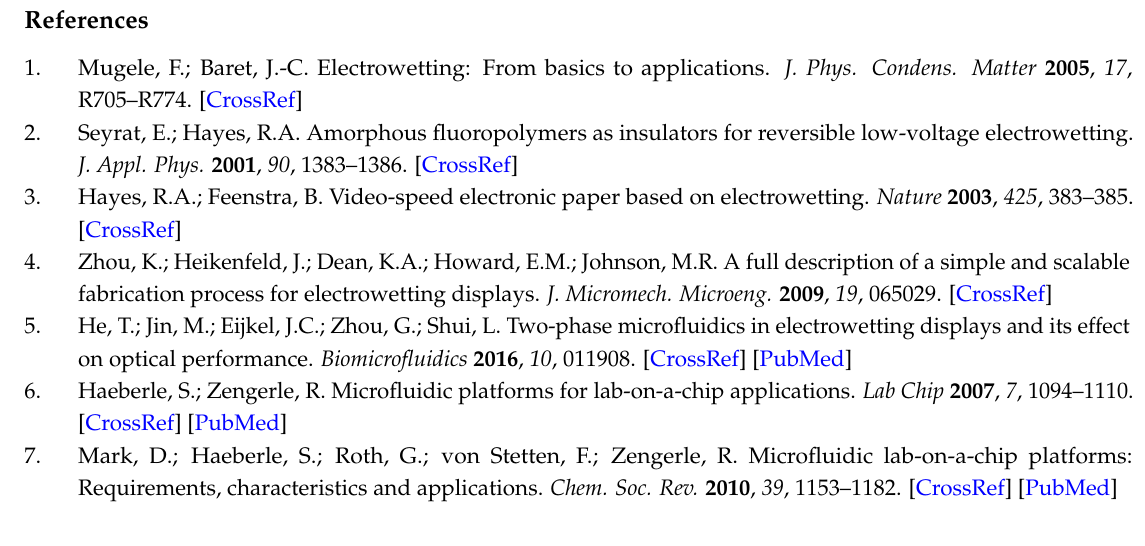
Figure S1: (a) Photograph of screen with 36 pads of 30 mm × 60 mm. Picture inset is the optical microscope photograph of mesh structure; (b) Amorphous fluoropolymer thickness data measured by stylus profiler on a 400 mm × 500 mm ITO glass substrate; Figure S2: Photoresist thickness data measured by stylus profiler on a 400 mm × 500 mm ITO glass